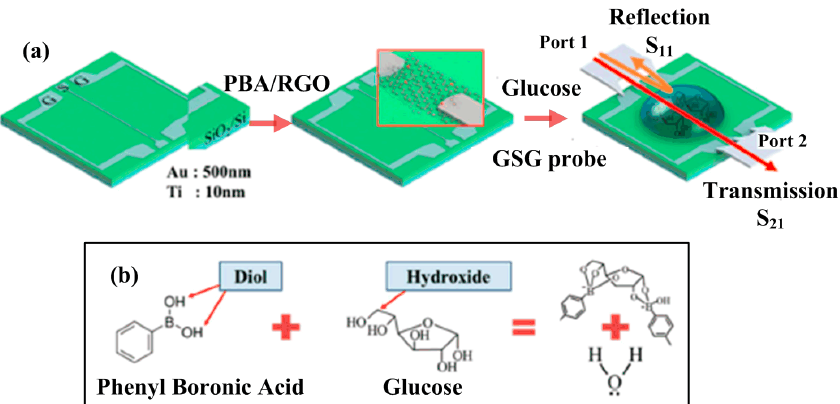
Figure 5. ( a ) Schematic of rGO-based sensor and measurement parameters of transmission (S 21 ) and reflection (S 11 ) coefficient in the two-port measurement system and ( b ) chemical reaction between phenylbutyric acid (PBA) and glucose [66]. Table 3. GO/rGO-based passive RF biosensors for wireless biosensing platform.